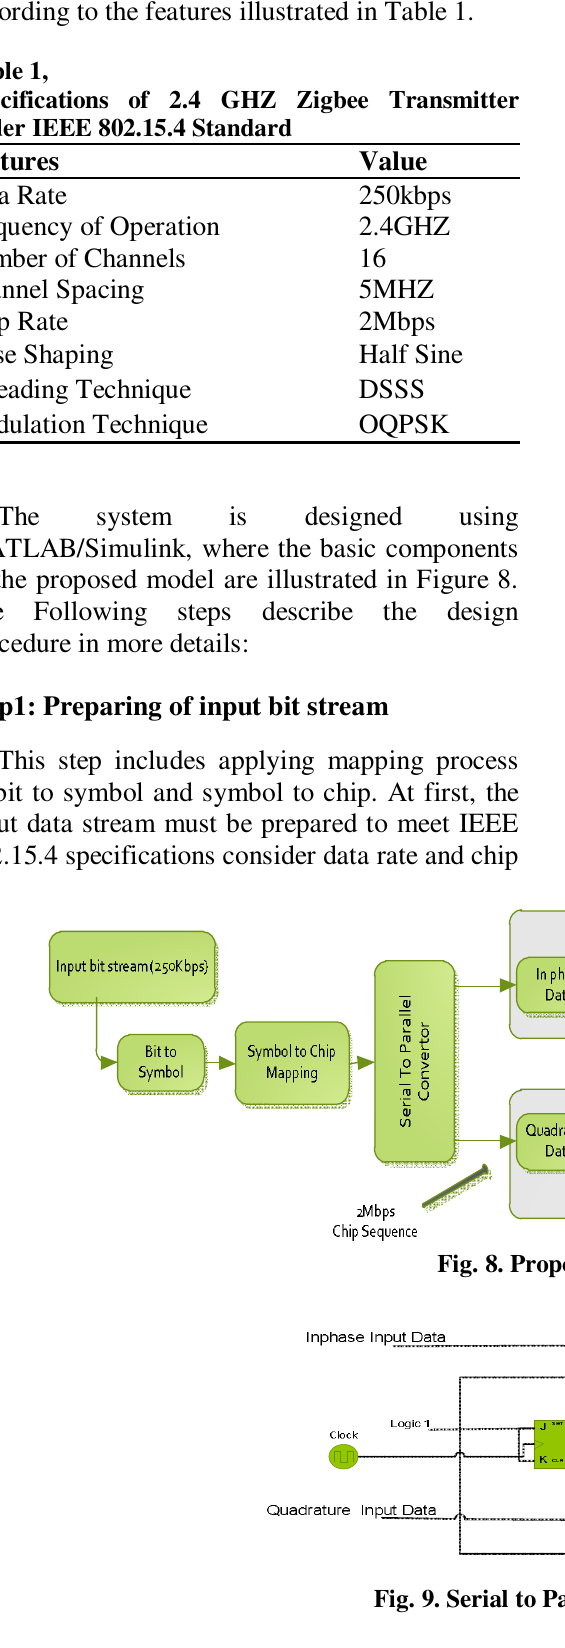
Fig. 9. Serial to Parallel